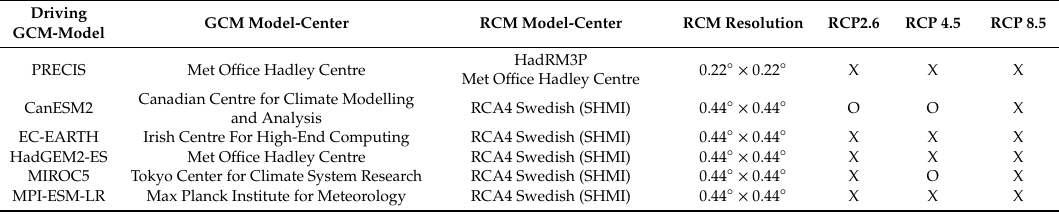
Table 1. General Circulation Models (GCMs) and Regional Climate Models (RCMs)